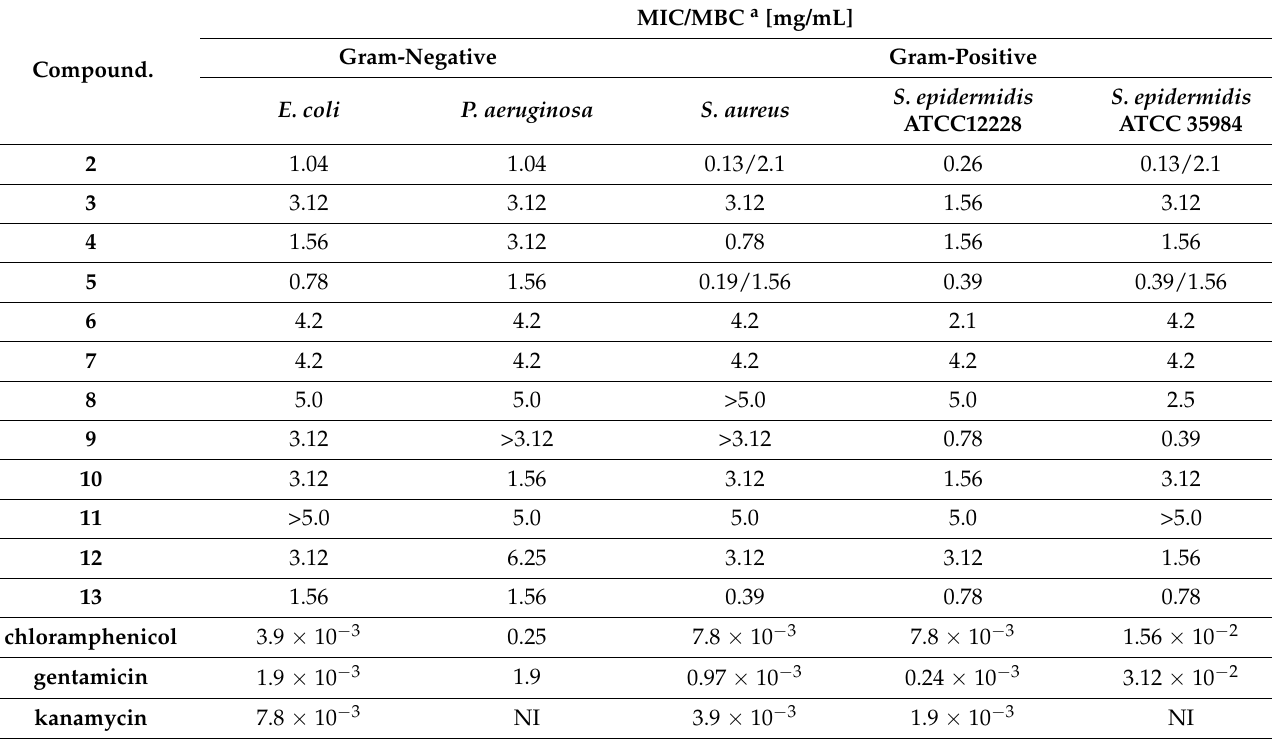
Table 2. Minimal inhibitory concentration (MIC) and minimal bactericidal concentration (MBC) values determined for coumarin-thiadiazole hybrids and their corresponding Cu(II) and Zn(II) complexes 2 – 13 .